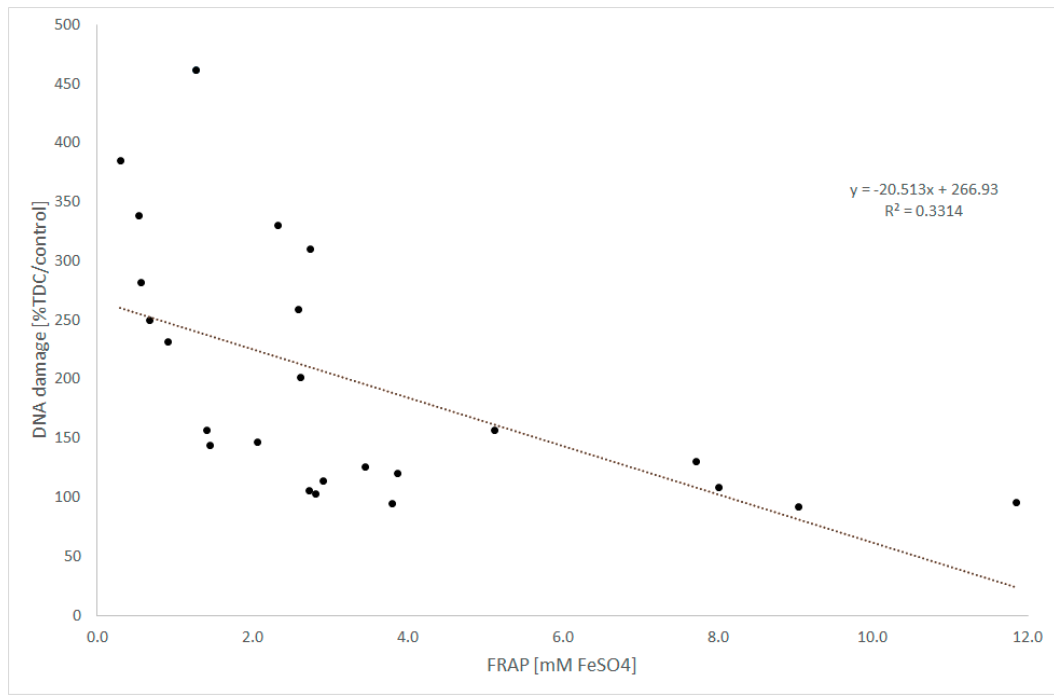
Figure 4. The relation between the genoprotective abilities of plant extracts and their antioxidant power. Lymphocytes were exposed to the extracts analyzed for 1 h. Oxidative DNA damage was induced by cell incubation in 25 μ M H 2 O 2 for 5 min. The results of the comet assay are expressed as tail DNA content (TDC) and are presented as % of control damages.